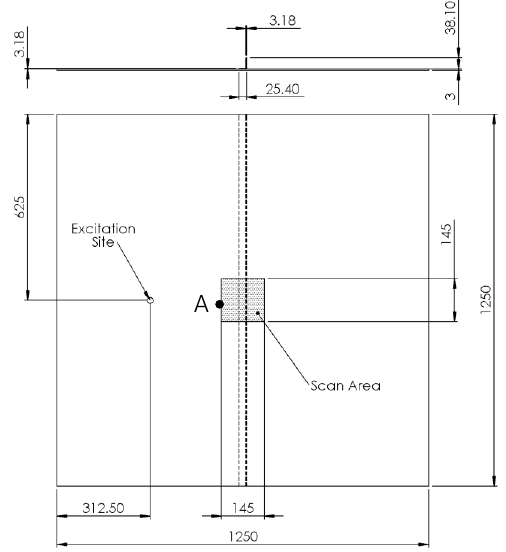
Figure 2. Dimensions of the stiffened panel (all dimensions in mm).